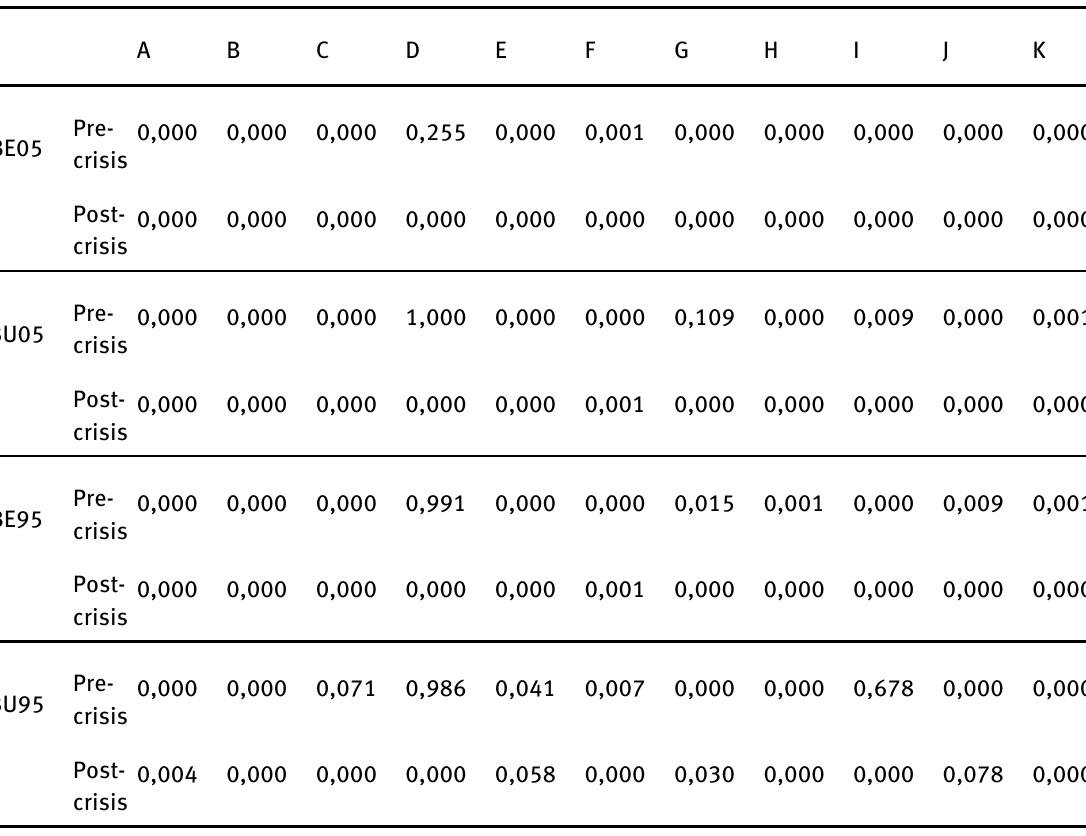
Table 10: Kolgomorov-Smirnov bootstrap p-values